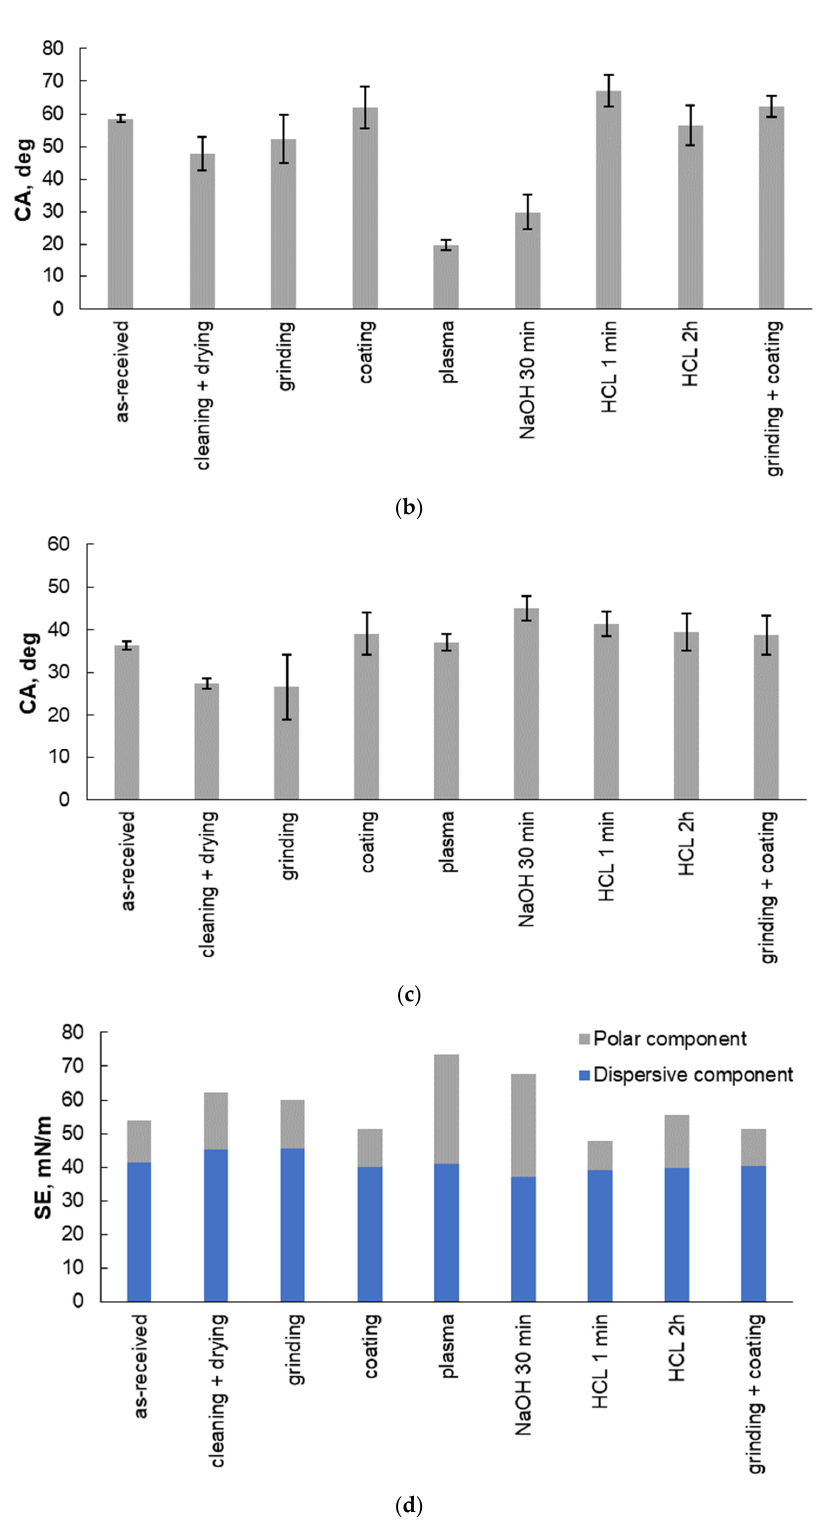
Figure 2. ( a ) Selected water droplet profiles and water contact angle evaluation; ( b ) Average water contact angles of the PI films; ( c ) Average diiodomethane contact angles of the PI films (the standard deviation calculated from 10 tests for each treated PI film is represented by the error bars); ( d ) Total surface free energy (SE) (with its polar and dispersive components) of the PI films before and after the different surface treatment